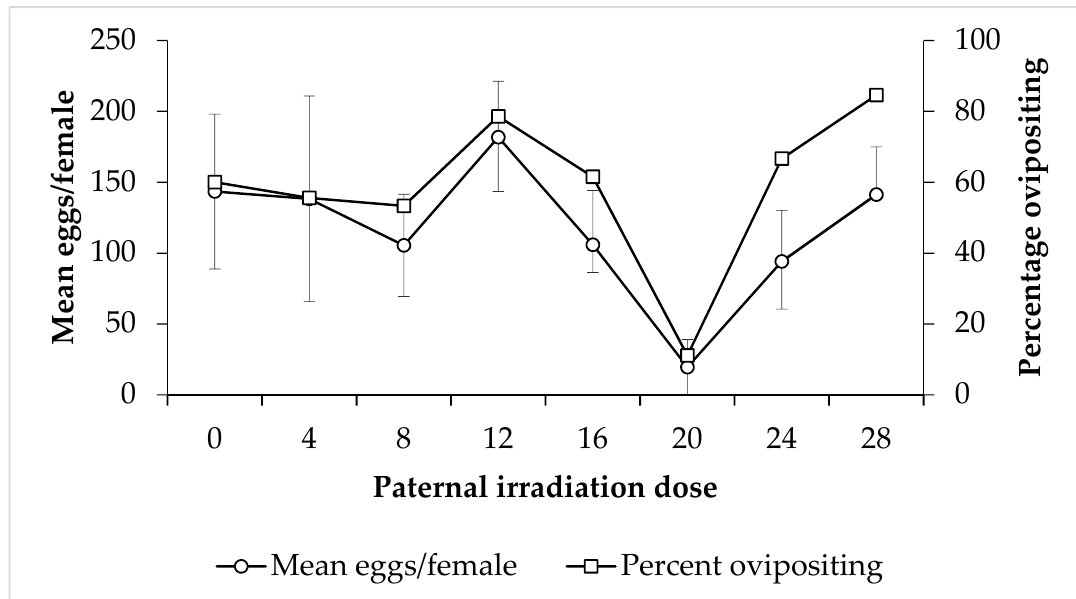
Figure 4. Mean number of eggs laid by untreated female Nezara viridula after mating with irradiated males (left axis), and the percentage of these females that laid eggs (right axis), separated by parental male irradiation dose. Error bars show standard error.